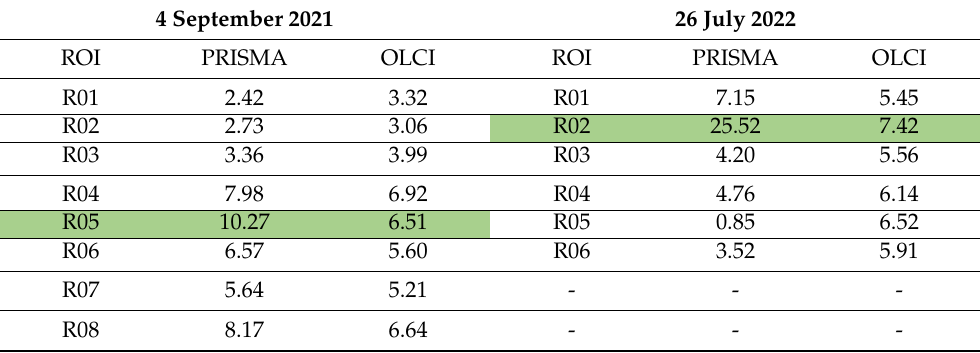
Figure 10. Comparison between OLCI (AC-corrected using ACOLITE) and PRISMA PC product maps using SIMIS05 model in Promissão Reservoir for ( a ) 4 September 2021 and ( b ) 26 July 2022. Table 6. Comparison between SIMIS05-retrieved PC (mg.m − 3 ) from PRISMA and OLCI images. The spatial distribution of the labeled stations is show in Figure 10. The station highlighted in green indicates the presence of bloom spots.